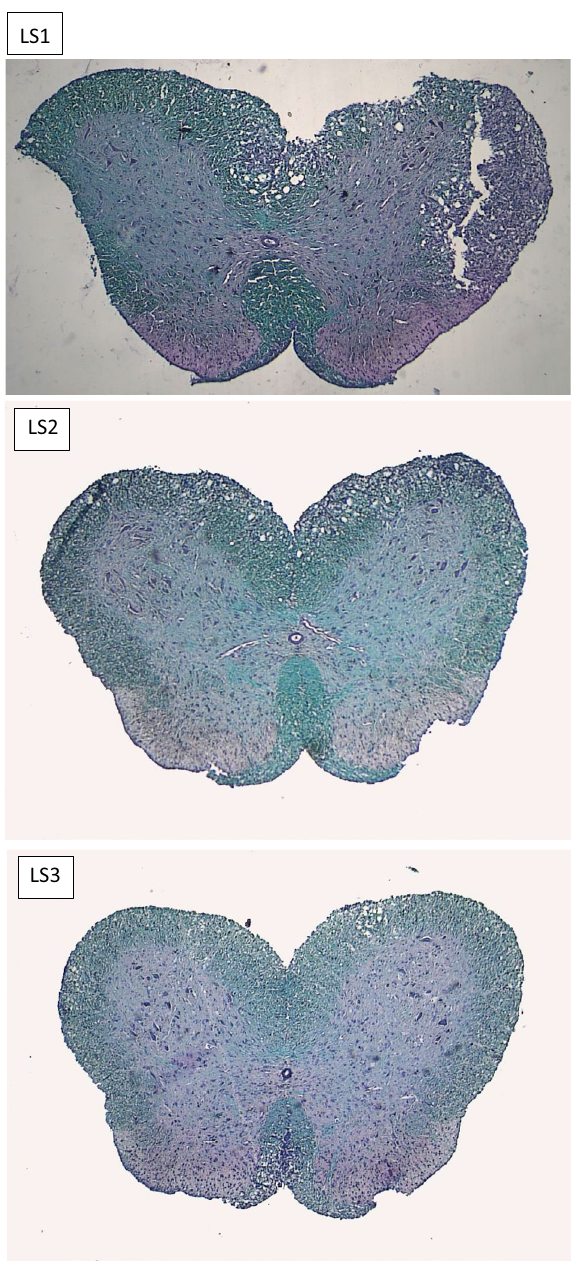
Figure 7. LFB stained pathological samples of first of spinal cord for demyelination comparison LS1 (EAE-first of spinal cord), LS2 (EAE-GA –end of spinal cord), LS3 (EAE-GA/Depot- end of spinal